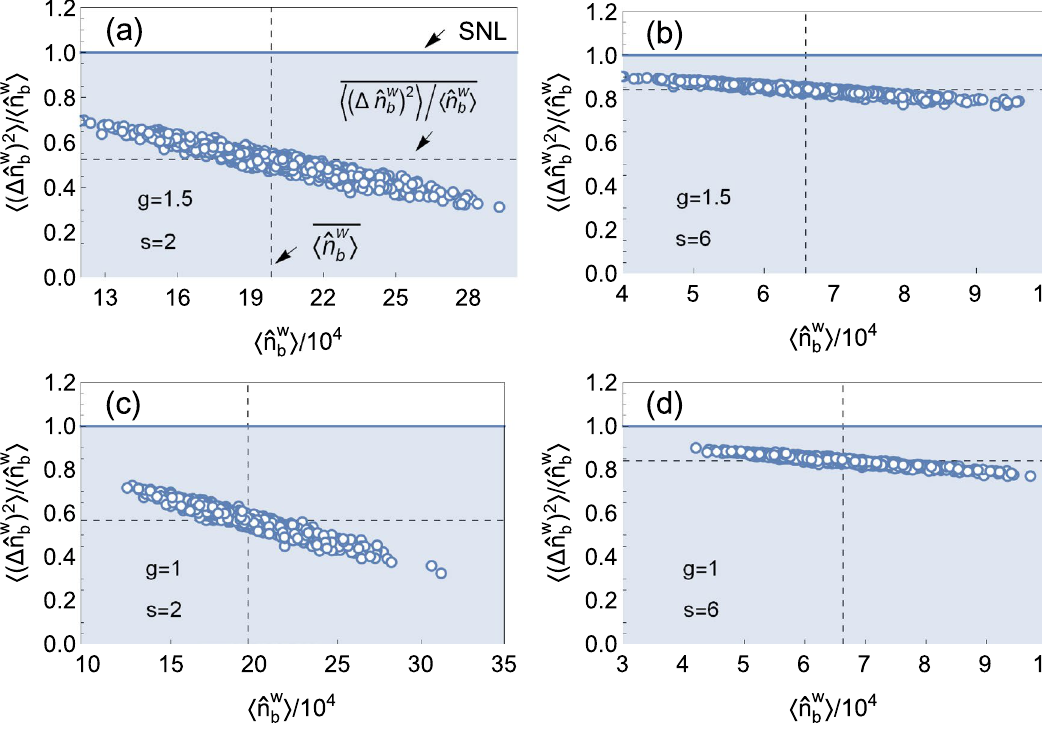
Figure 4. Numerical simulation of Fano factor of the focused mode. Each point corresponds to one Fano factor. The numerical experiments have been repeated for 1000 times. In each simulation circle, the scattering matrix is generated randomly. The input beam is the photon-number squeezed state 2 50 10000 , N α Parameters: = | | =